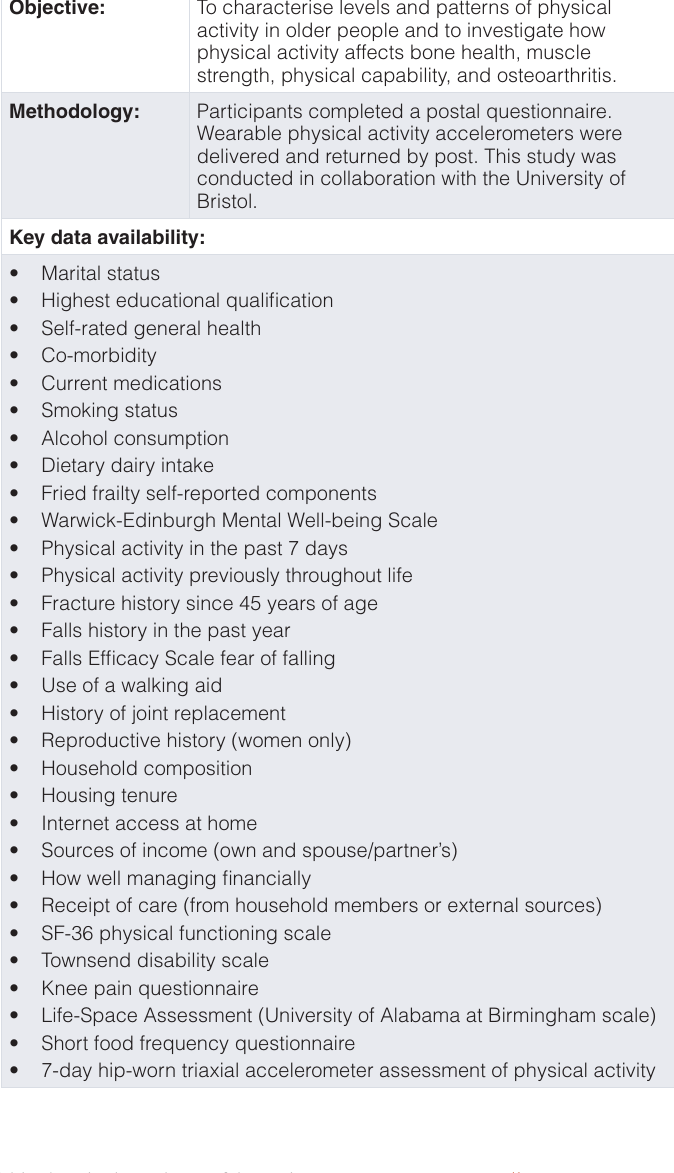
Table 10. Hertfordshire Cohort Study Vertical Impact on Bone in the Elderly (VIBE) study.